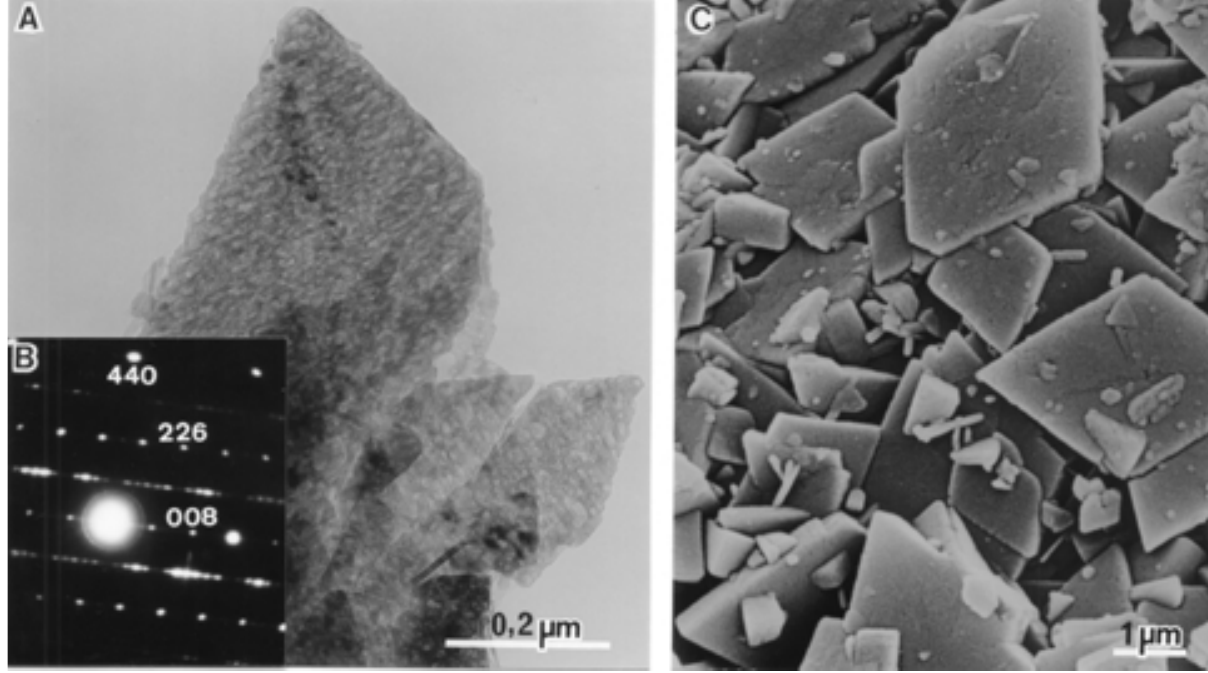
Figure 6. delta-Al 2 0 3 (A) - transmission electron micrograph; (B) - selected area electron diffraction pattern; (C) scanning electron